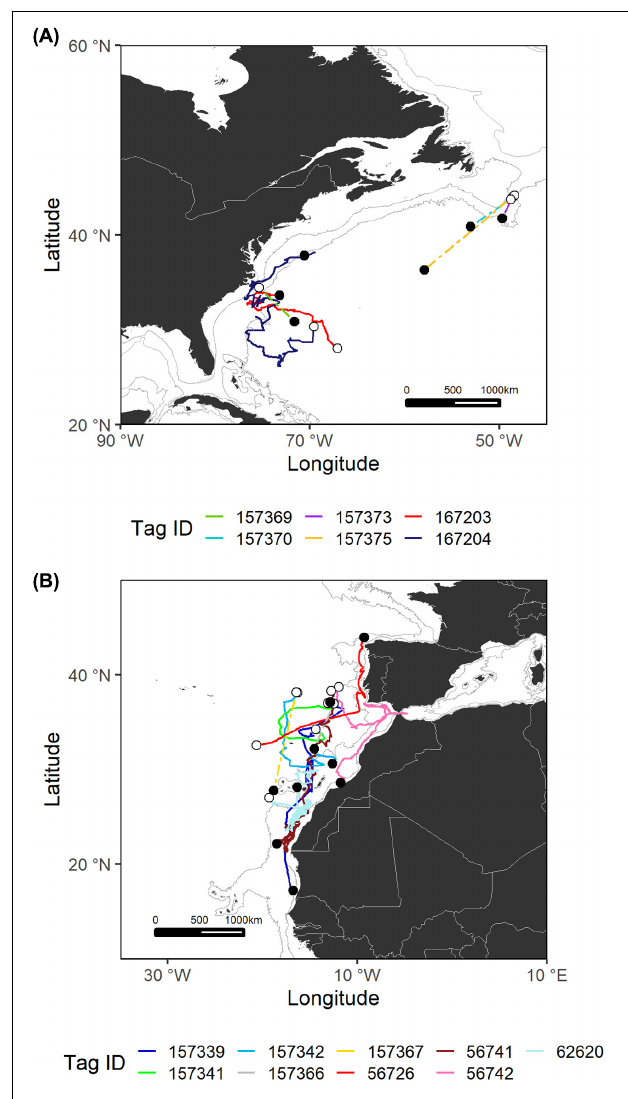
FIGURE 2 | Estimated most likely tracks for each shortfin mako tagged in the Northwest Atlantic (A) and Northeast Atlantic (B) regions. The tagging locations are represented with open circles and the pop-up locations with black circles. Note that for sPATs only straight line tracks are shown (dashed lines). Gray lines represent the boundaries of continental and insular margins (140–3,500 m